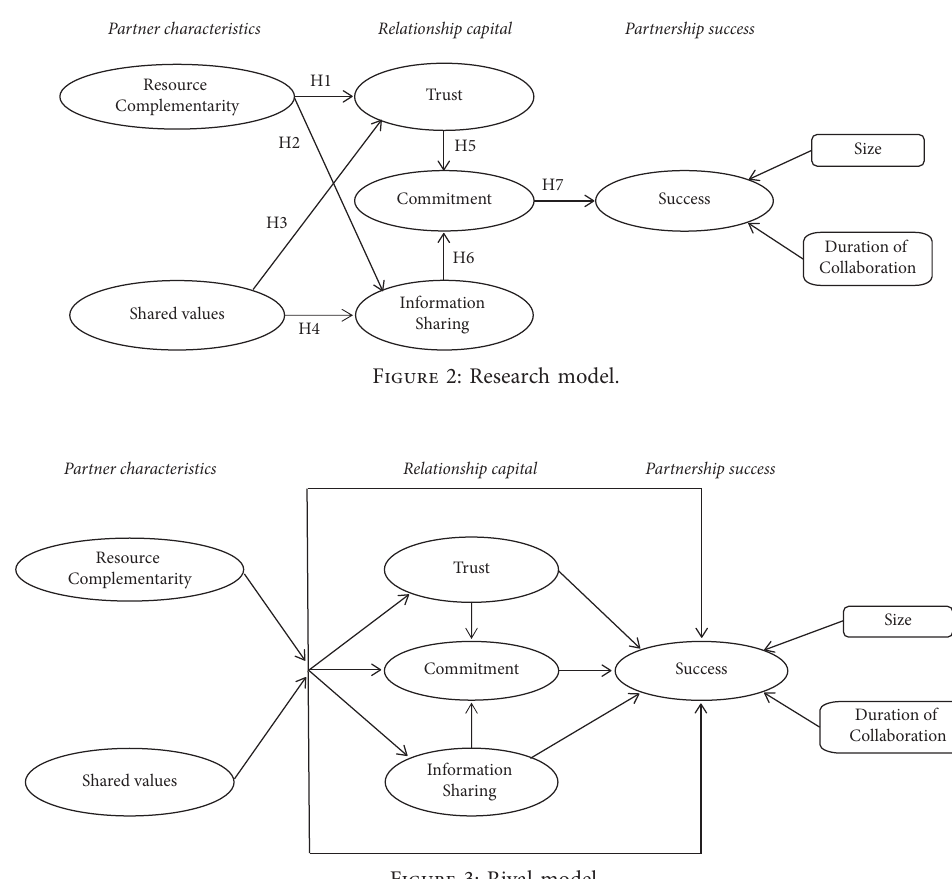
Figure 3: Rival model.